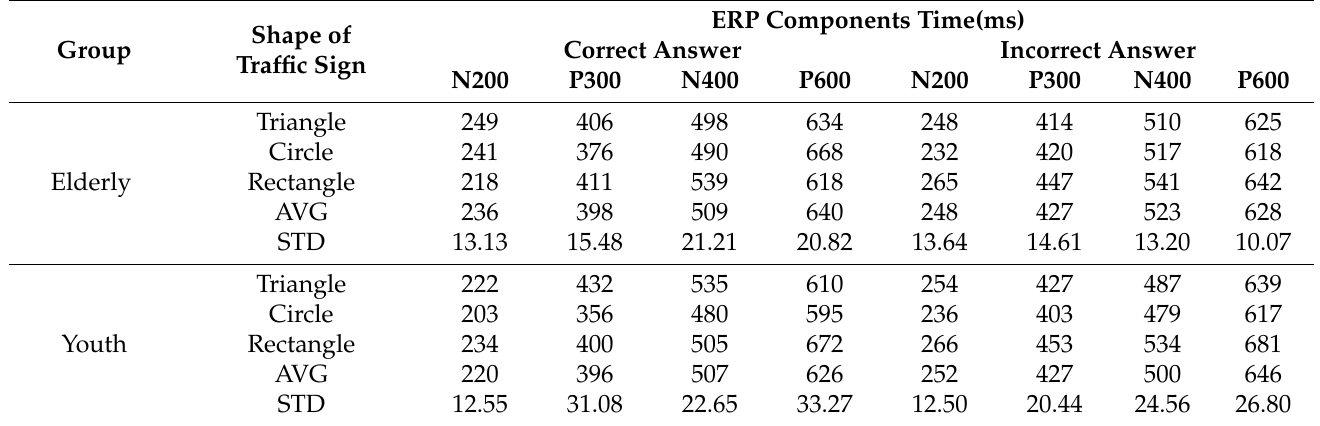
Table 3. As a result of detection by zero-phase and band-pass filtering, there were differences by figure, but the difference between correct/incorrect answers was clearly seen in P300/P400 of the elderly and N200/P300 of the young.